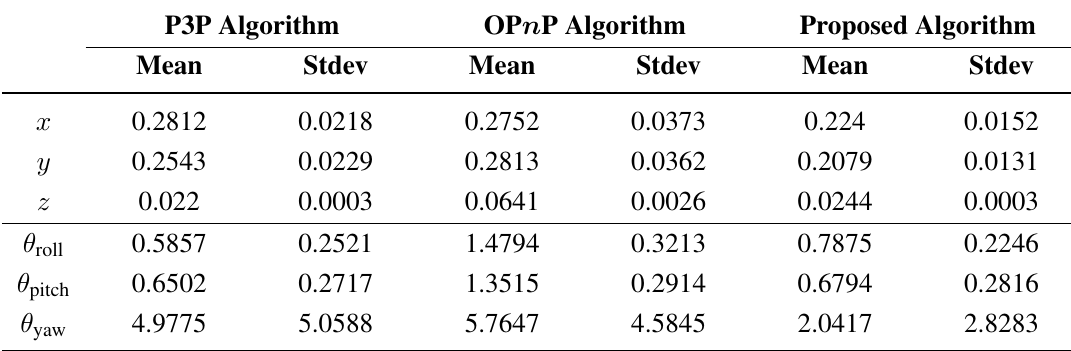
Table 2. Comparison of the error statistics of the conventional and the proposed algorithms in the indoor environment (Unit: m,